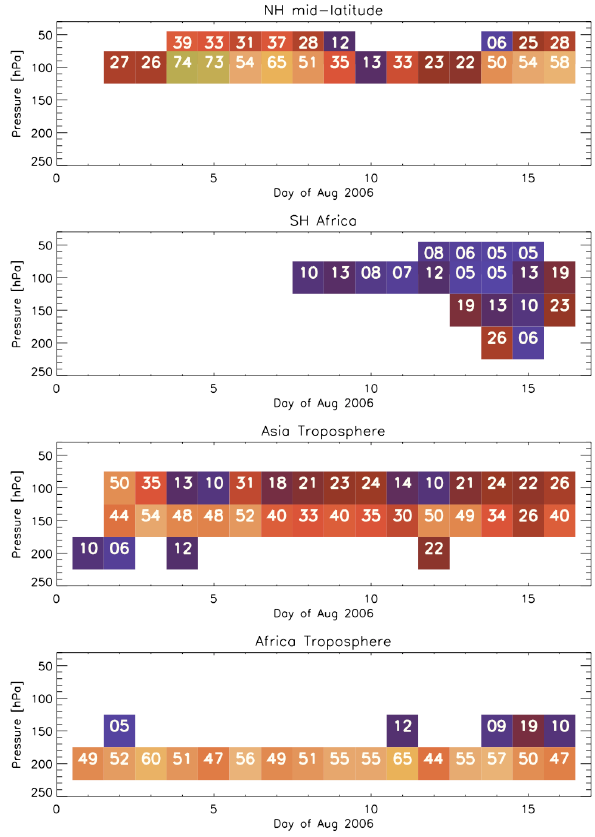
Fig. 4b. Same as Fig. 4a but based on 10 day back trajectories traced back from a sub-domain including the M55 flight tracks (8 ◦ E to Figure 4b: Same as Figure 4a but based on 10 day back trajectories traced back from a sub-2 5 ◦ W and 5 to 15 ◦ domain including the M55 flight tracks (8E to 5W and 5 to 15N). 3